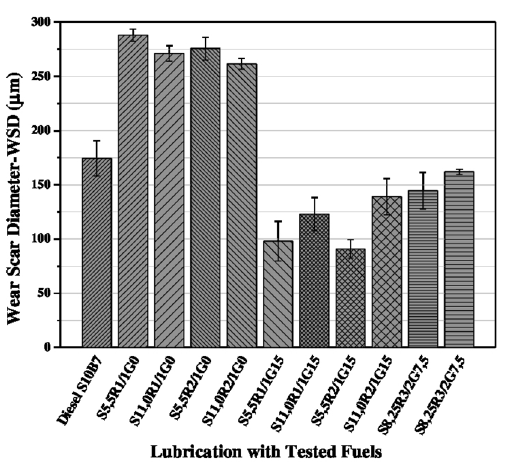
Figura 5. WSD of the balls used for the HFRR tests.